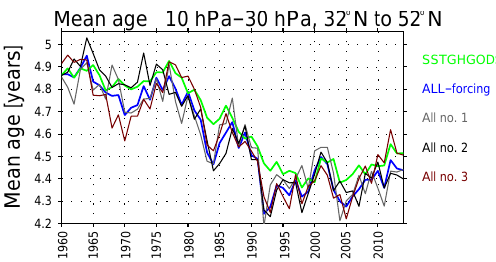
Figure 8. Modeled annual averaged mean age in the NH mid- stratosphere between 30 and 10hPa in each of the three all-forcing GEOSCCM integrations. Thin lines denote individual integrations, while thick lines denote ensemble means. For clarity, we also in- clude the ensemble mean of the SSTGHGODS simulation.